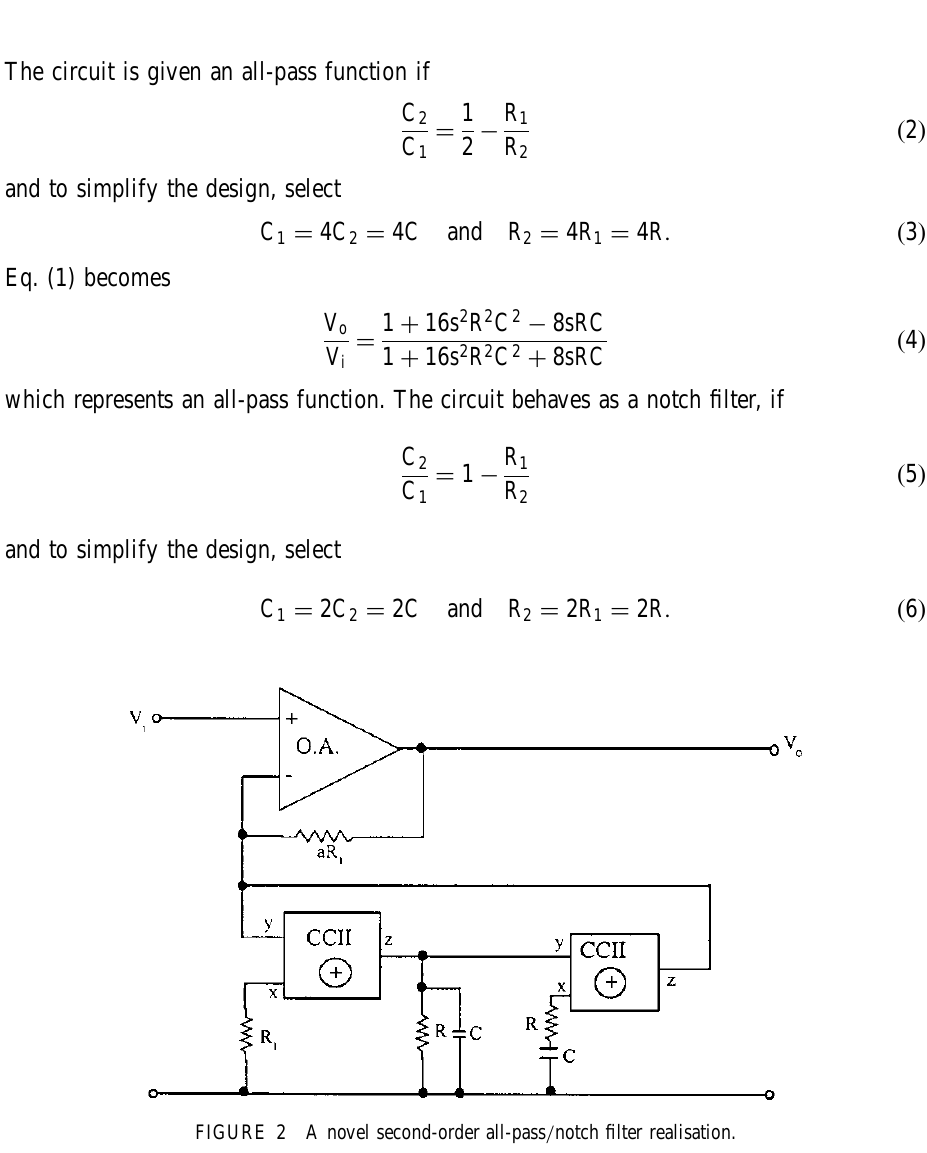
FIGURE 1 An active second-order all-pass = notch filter.